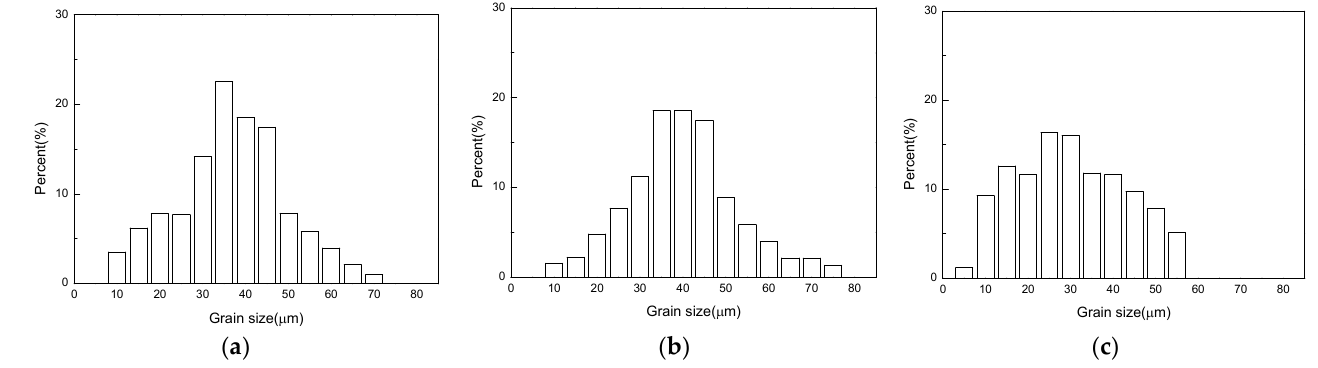
Figure 5. The grain size of ZCL205A alloy deposits manufactured with different deposition processes held at 200 °C for 30 min. ( a ) The distribution of grain size in a sample manufactured using the CMT process; ( b ) the distribution of grain size in a sample manufactured using the CMT and Pulse process; ( c ) the distribution of grain size in a sample manufactured using the CMT Pulse and Advanced process. The average grain size is counted using the software contained in the EBSD. The average grain size of the ZL205A alloy deposited with the CMT process at high temperature is 43.45 µ m. The average grain size of the ZL205A alloy stack deposited with the CMT Pulse process at high temperature is 50.15 µ m. The average grain size of the ZL205A alloy stack deposited with the CMT Pulse Advanced process at high temperature is 26.43 µ